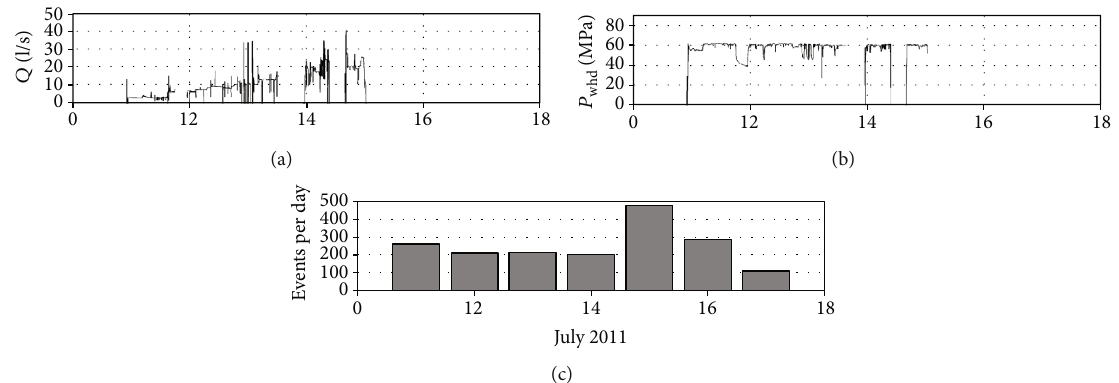
Figure 3: (a) Injection rate, (b) wellhead pressure, and (c) daily rate of induced events as a function of time during the main stimulation of Paralana-2. Time window is restricted to 10 th -17 th of July 2011 when the surface stations of the seismic monitoring network were in operation. Injection was terminated on 15 th of July 2011 after injecting a total volume of approximately 3,100m 3 [17]. Seismic activity continued after the injection period. Hydraulic data taken from daily operation reports. Note that the time basis of hydraulic data reported by Albaric et al. [17] and Hasting et al. [18] seems to be partly inconsistent with the daily operation reports.